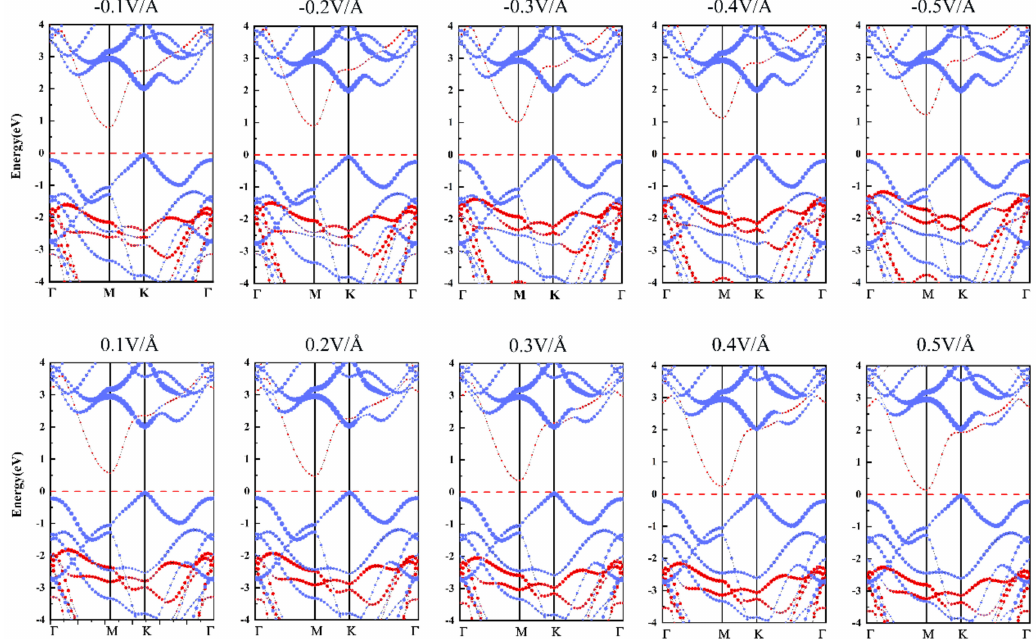
Figure 7. Projected band structures of the SiS 2 / WSe 2 hetero-bilayers under di ff erent external electric fields obtained by the HSE06 method; red and blue lines are bands contributed by SnS 2 and WSe 2